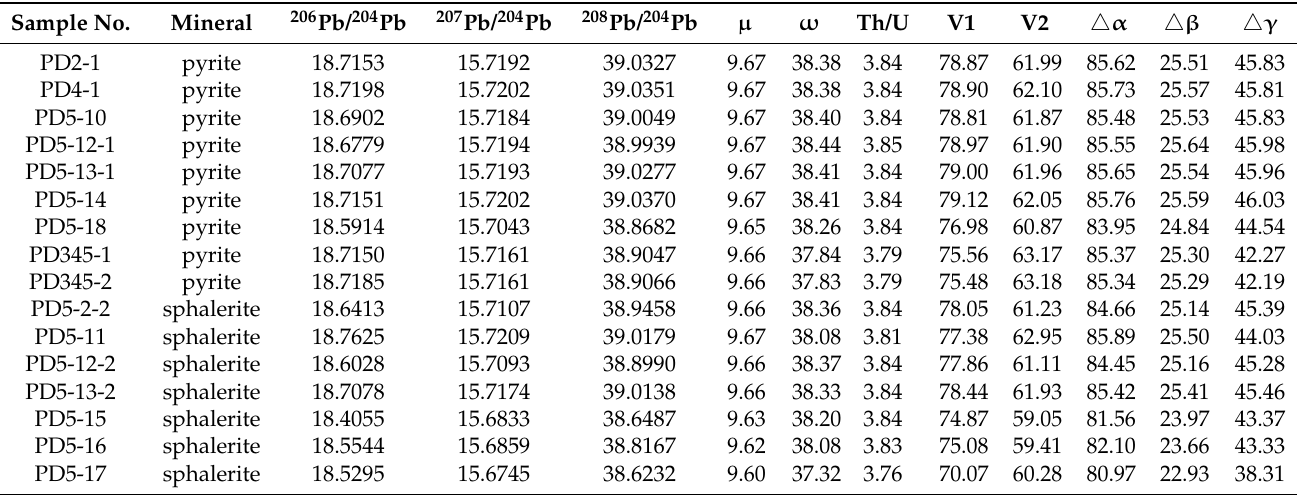
Table 4. Lead isotopic compositions of the Bawang